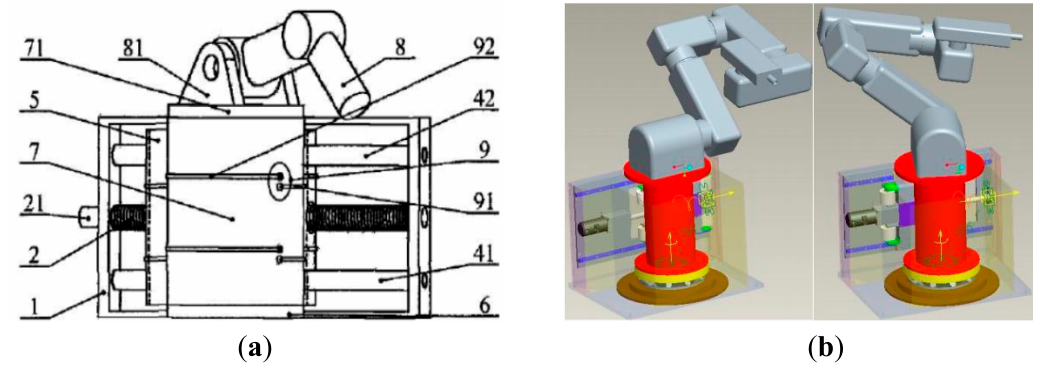
Figure 7. A novel design of laser-in-frame robotic manipulator for laser-driven VHE electron/photon beam therapy. ( a ) The design concept of rotary joint; ( b ) The whole